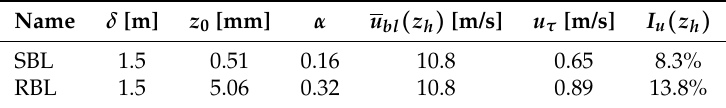
Table 1. Characteristics of the turbulent boundary